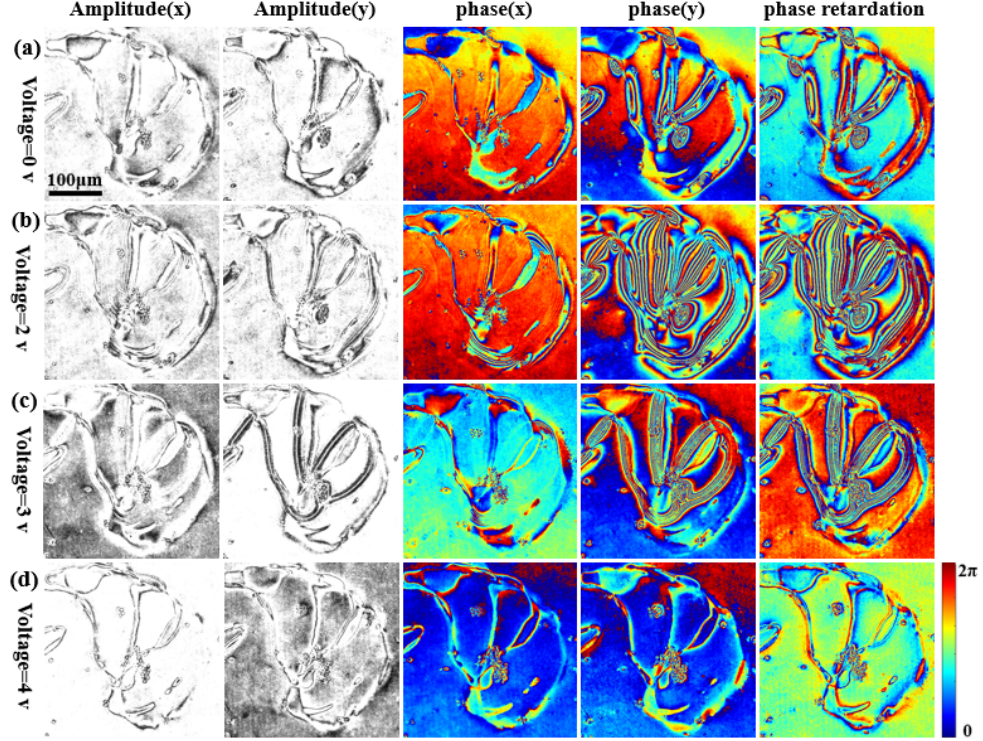
Figure 7. Complex amplitude distribution and phase delay distribution results for liquid crystal cell in orthogonal polarization directions for different applied voltages. ( a – d ) Are the measurement results for the liquid crystal cell for voltages of 0 V, 2 V, 3 V, and 4 V, respectively; from left to right, they are the amplitude distribution, phase distribution, and phase delay in the two orthogonal polarization directions.